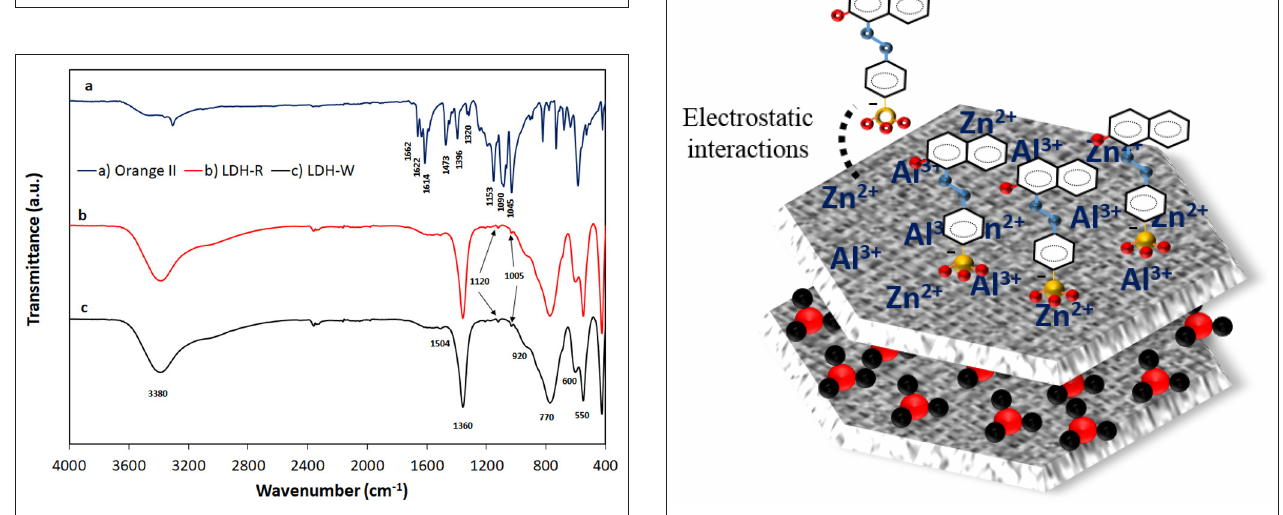
FIGURE 10 | The XRD patterns of (A) LDH–R and (B) LDH–W after Orange II adsorption.